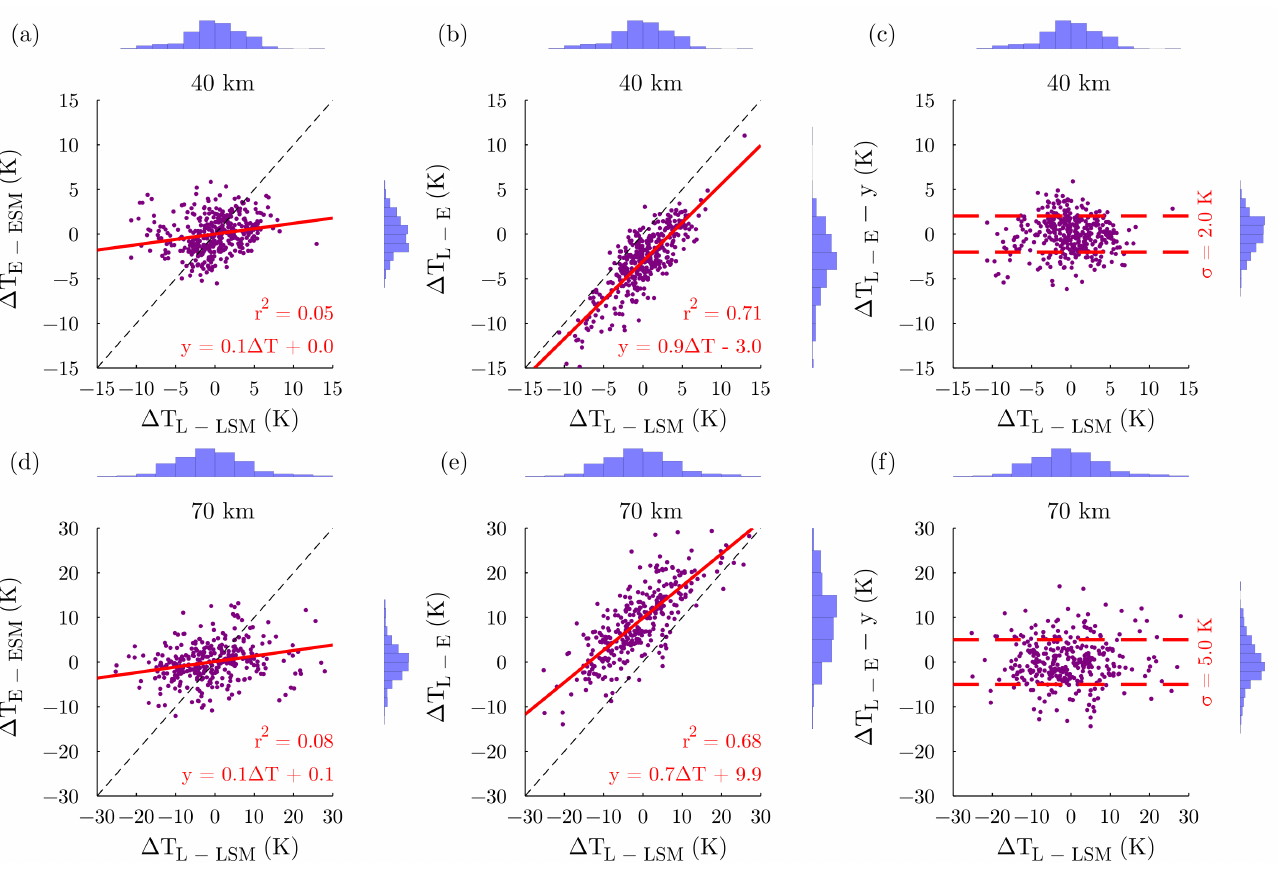
Figure 4. Comparisons of the temperature differences between ERA-5 and its seasonal mean ( ∆ T E − ESM ) and between the LiDAR and ERA-5 ( ∆ T L − E ) with the temperature differences between the LiDAR and its seasonal mean ( ∆ T L − LSM ) at 40 km ( a , b ) and 70 km ( d , e ) during summer. A perfect correlation without bias is illustrated by the black dashed line. The temperature differences between the LiDAR and the ECMWF corrected by the linear regression ( ∆ T L − E − y) are shown at 40 km ( c ) and 70 km ( f ). The same information regarding the performed linear regressions and the distribution of temperature differences as contained in Figure 3 are displayed. Table 2. The same information as contained in Table 1, but for the summer